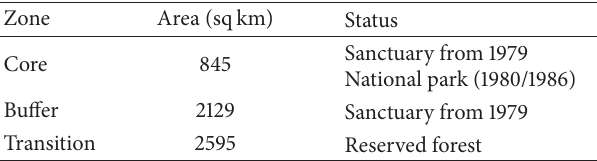
Table 1: Area and status of SBR since